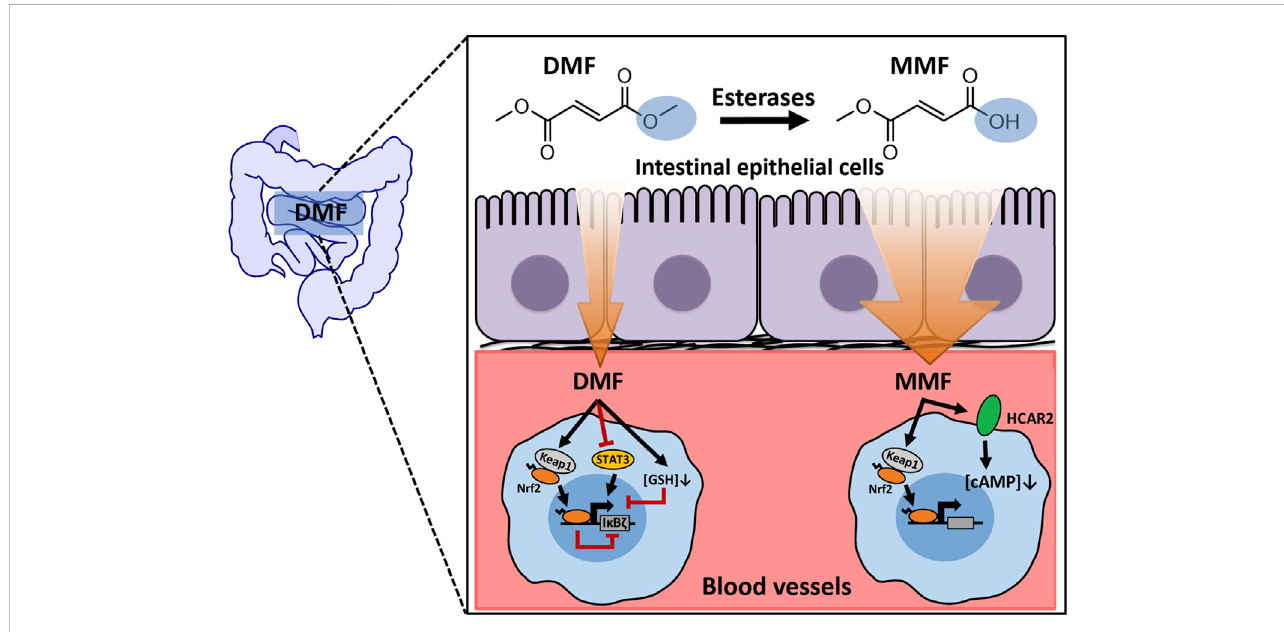
FIGURE 9 A working model depicting the mechanisms of I κ B ζ expression regulated by short-term exposure to